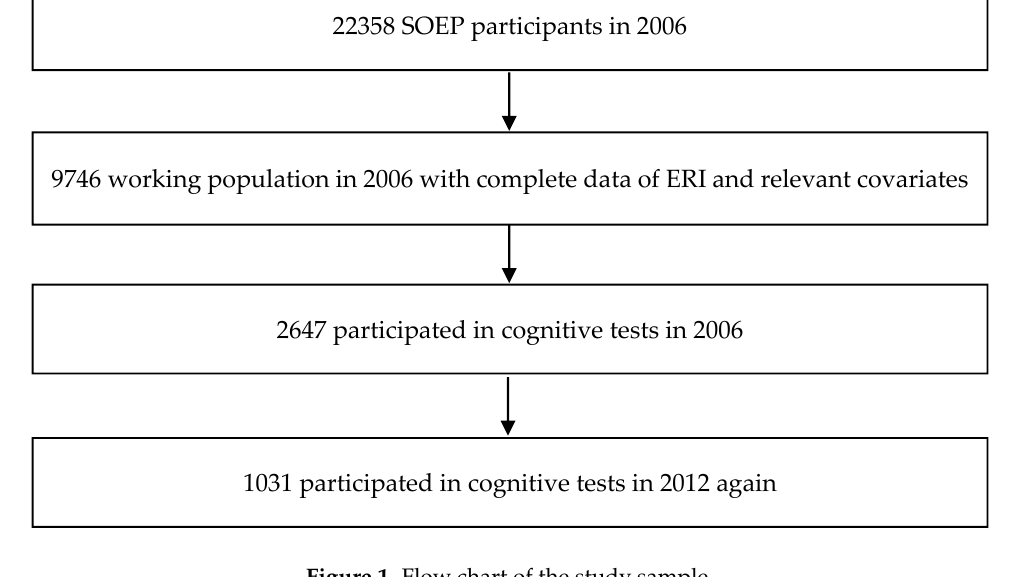
Figure 1. Flow chart of the study sample.